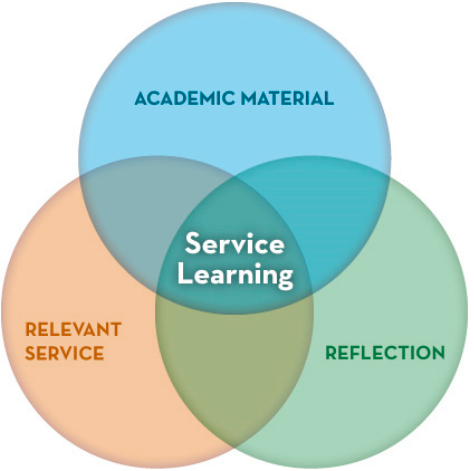
Figure 1. Components of service learning. Source: Loyola University New Orleans (http://www.loyno.edu/engage/service-learning). Accessed on 10 August 2022.